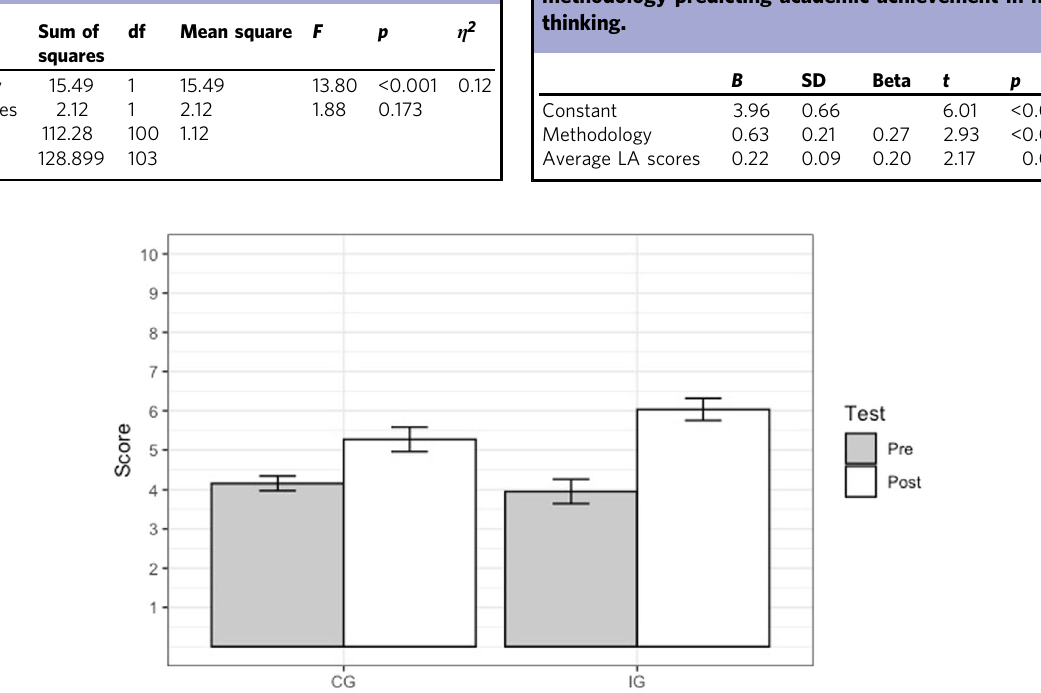
Table 2 One-way ANCOVA results using pre-test scores and methodology to examine the effect on academic performance.